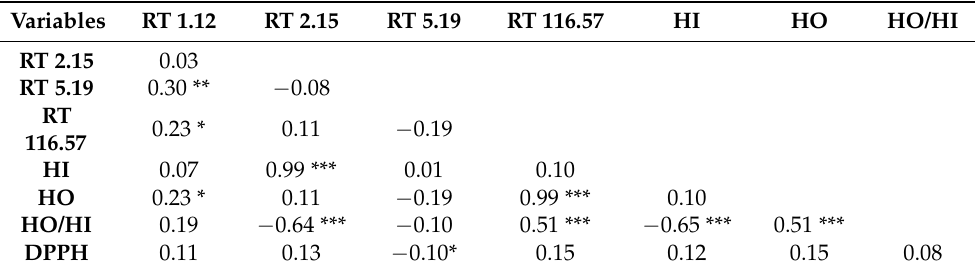
Table 3. Correlation values for retention time, peptides proportion, and antioxidant effect in the NNP fraction in Mexican goat surface mold cheese with prolonged